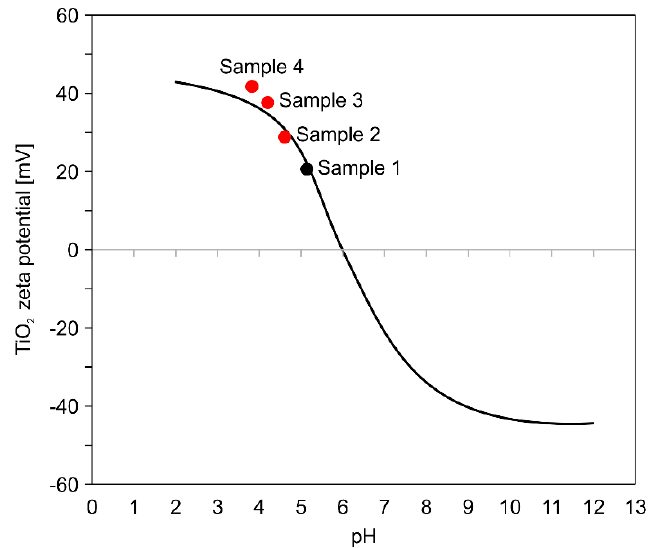
Figure 9. Changes in pH and zeta potentials of TiO 2 colloid samples such as sample 1 (0 min), sample 2 (15 min), sample 3 (84 min), and sample 4 (120 min) after various ultrasonic wave exposure times.